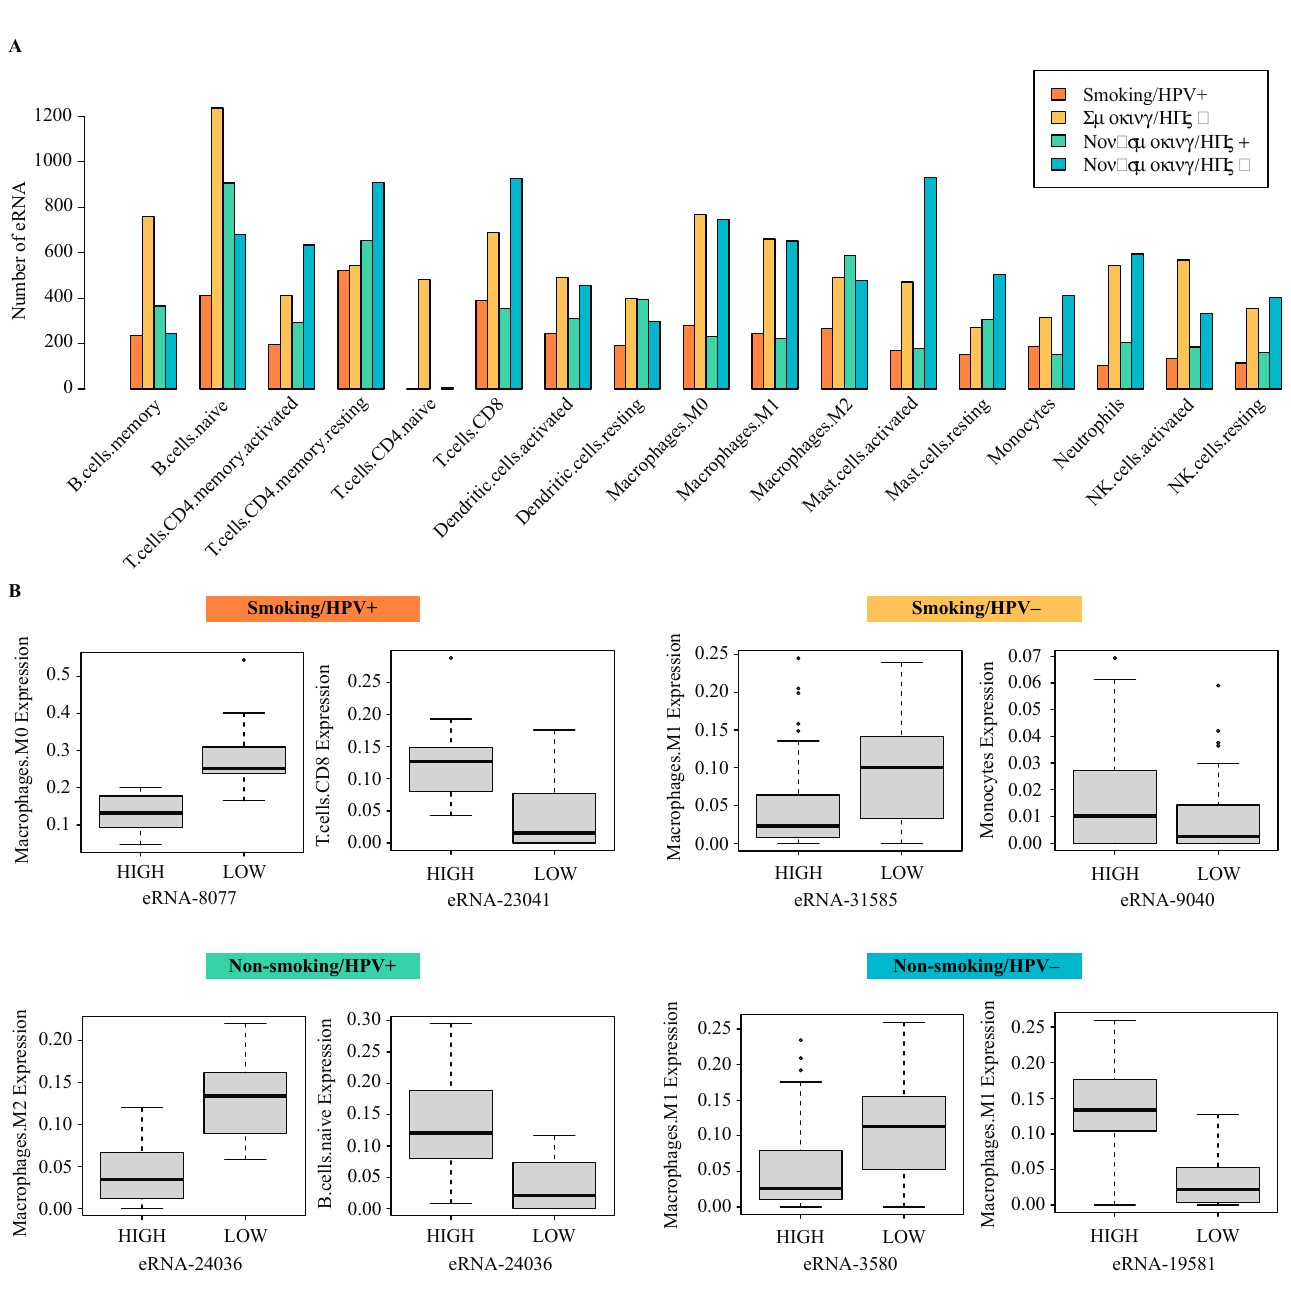
Figure 5. Correlation of differentially expressed eRNA to immune cell populations. ( A ) Bar plot of the number of eRNA correlated to immune cell types in each of the four study cohorts. ( B ) Box plots showing the correlation of eRNA to immune cell types from each of the four study cohorts with outliers represented by ◦ . Cibersortx was used to estimate immune cell populations in patient samples, and subsequently, Kruskal–Wallis test was used to determine associations between immune cell types and eRNA expression.